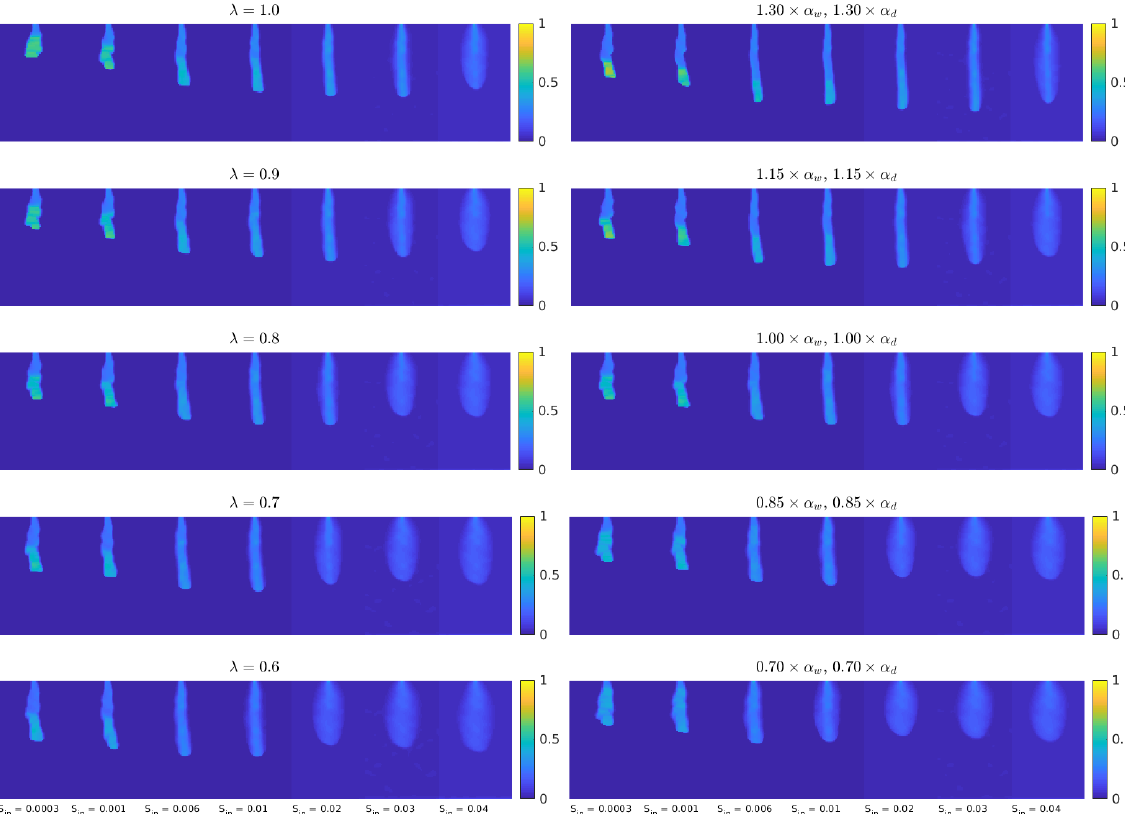
Figure B6. A snapshot of the saturation field at 25min for the intrinsic permeability distribution shown in Fig. B1a for seven different values of initial saturation S in and five different values of λ (left column) and for seven different values of initial saturation S in and five different values of α (right